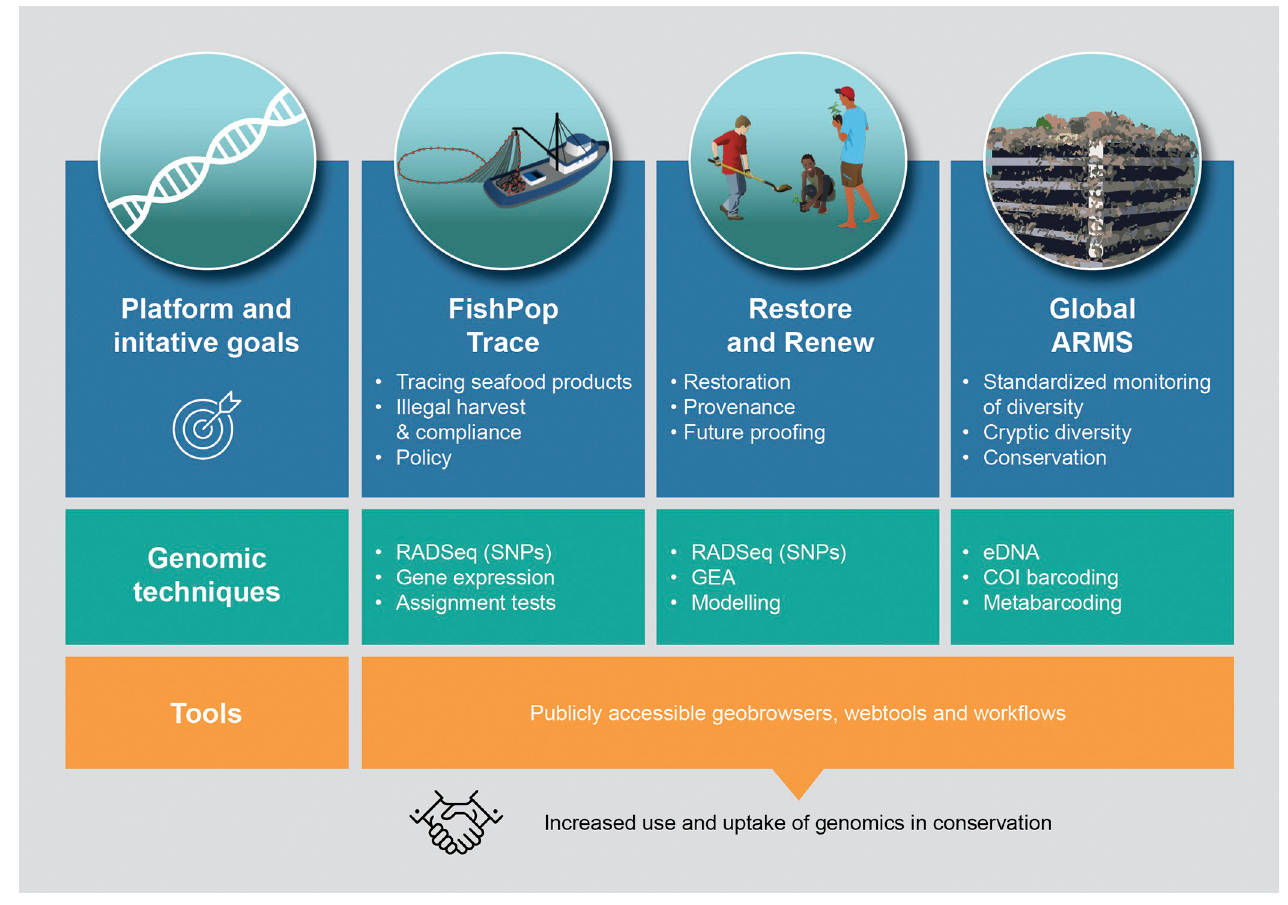
Fig 2. Tools, techniques, and platforms for using genomic data in marine conservation. Examples of applied online tools and platforms that assist biodiversity managers and conservation practitioners in the use genomic data. GEA; genotype-environment associations.